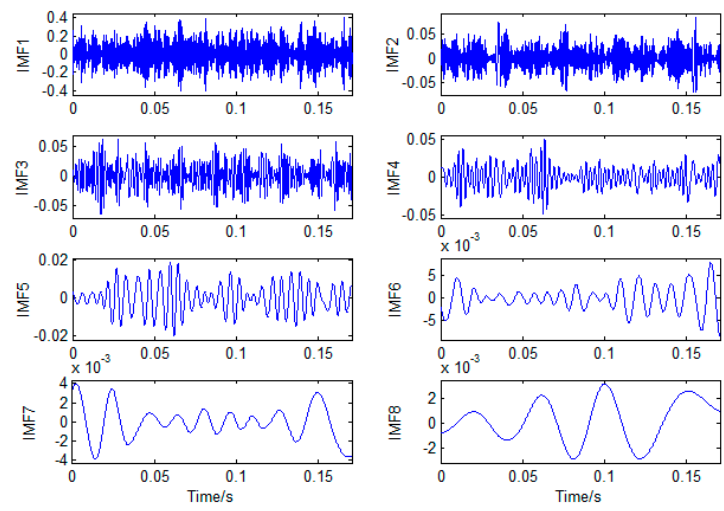
Figure 8. Eight-order IMFs of a BF signal decomposed by ensemble empirical mode decomposition (EEMD).